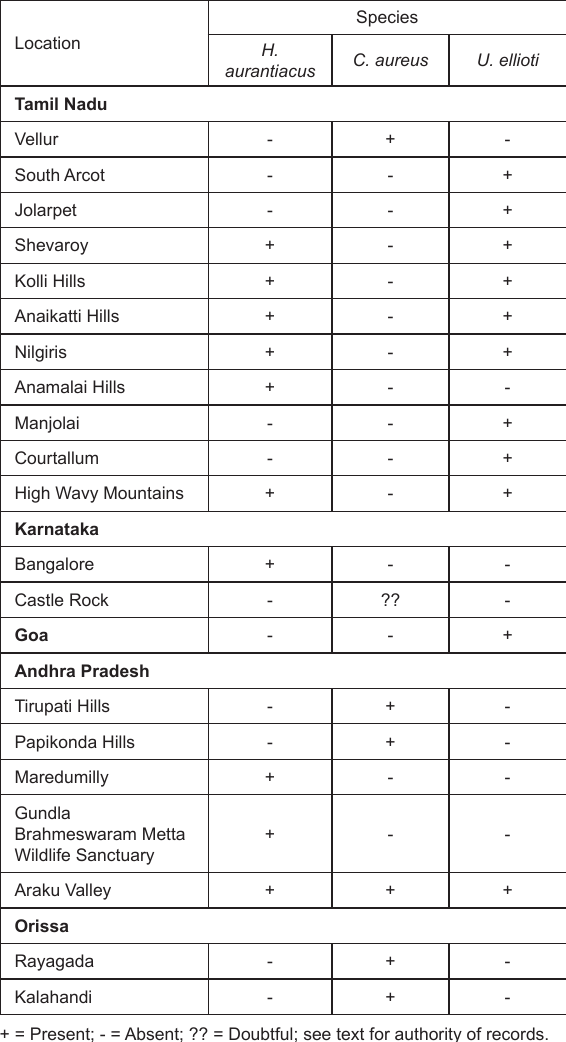
+ = Present; - = Absent; ?? = Doubtful; see text for authority of records.